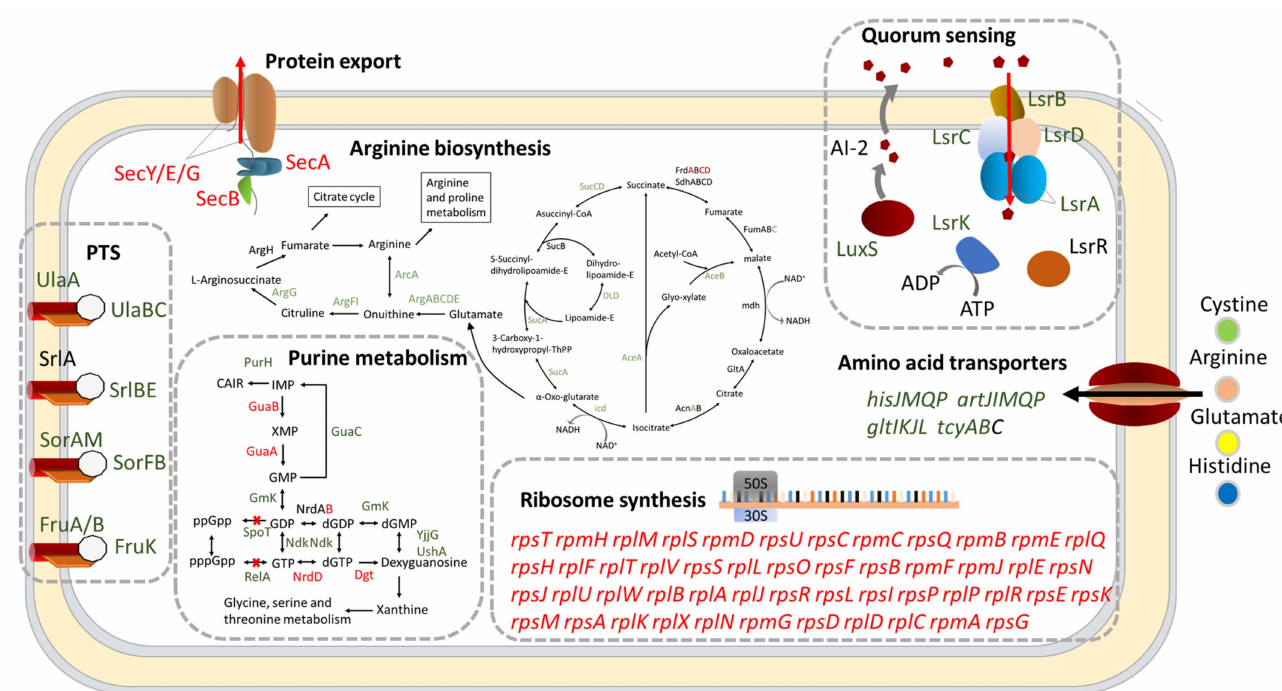
Figure 4. The model for the cellular processes of ∆ dksA . Red, green, and black indicate significant upregulation (FC > 2 and p -adjust < 0.05), significant downregulation (FC < 0.5 and p -adjust < 0.05), and no significant regulation (0.5 ≤ FC ≤ 2 or p -adjust ≥ 0.05), respectively.